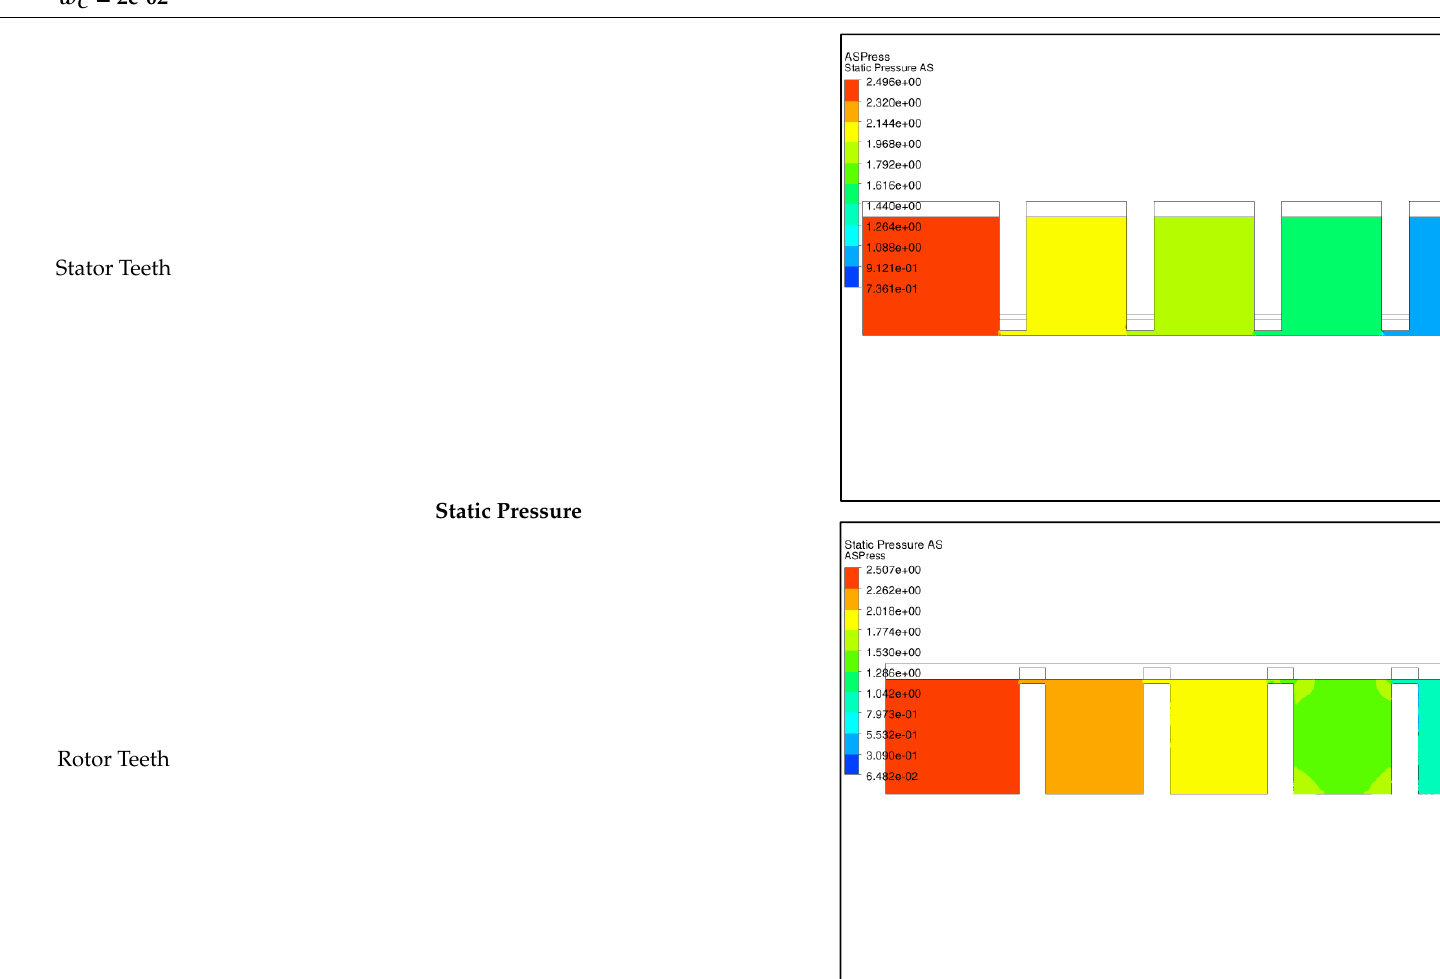
Table A8. Static pressure fields.